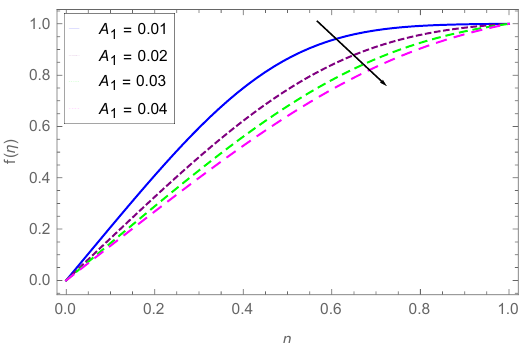
Figure 16. Graph displaying f ( η ) dependence on A 1